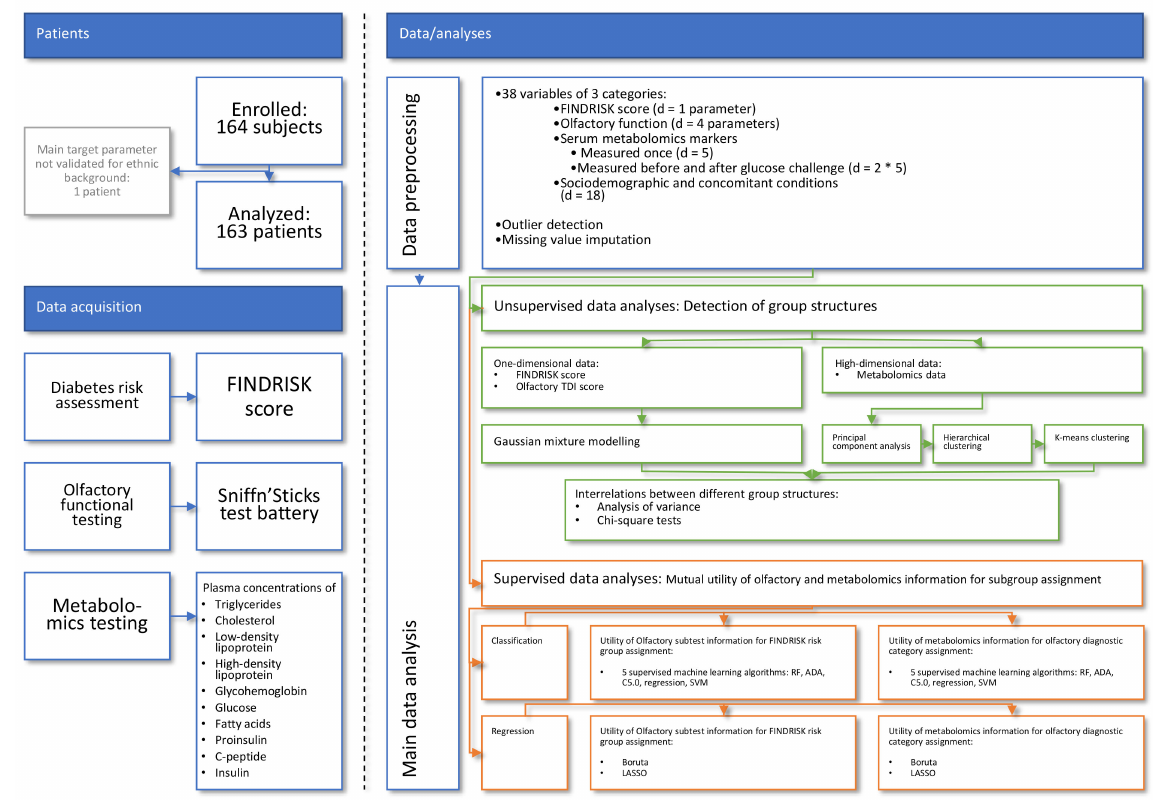
Figure 1. Flowchart showing the number of patients, the main items of data acquisition, and the steps of data analysis. The main steps of data analysis ranged from preprocessing to unsupervised and supervised analyses that assessed the extent to which olfactory and metabolomics databased subgroup assignments were mutually identified from the respective information. The figure has been created using Microsoft PowerPoint ® (Redmond, WA, USA) on Microsoft Windows 11 running in a virtual machine powered by VirtualBox 6.1 (Oracle Corporation, Austin, TX,